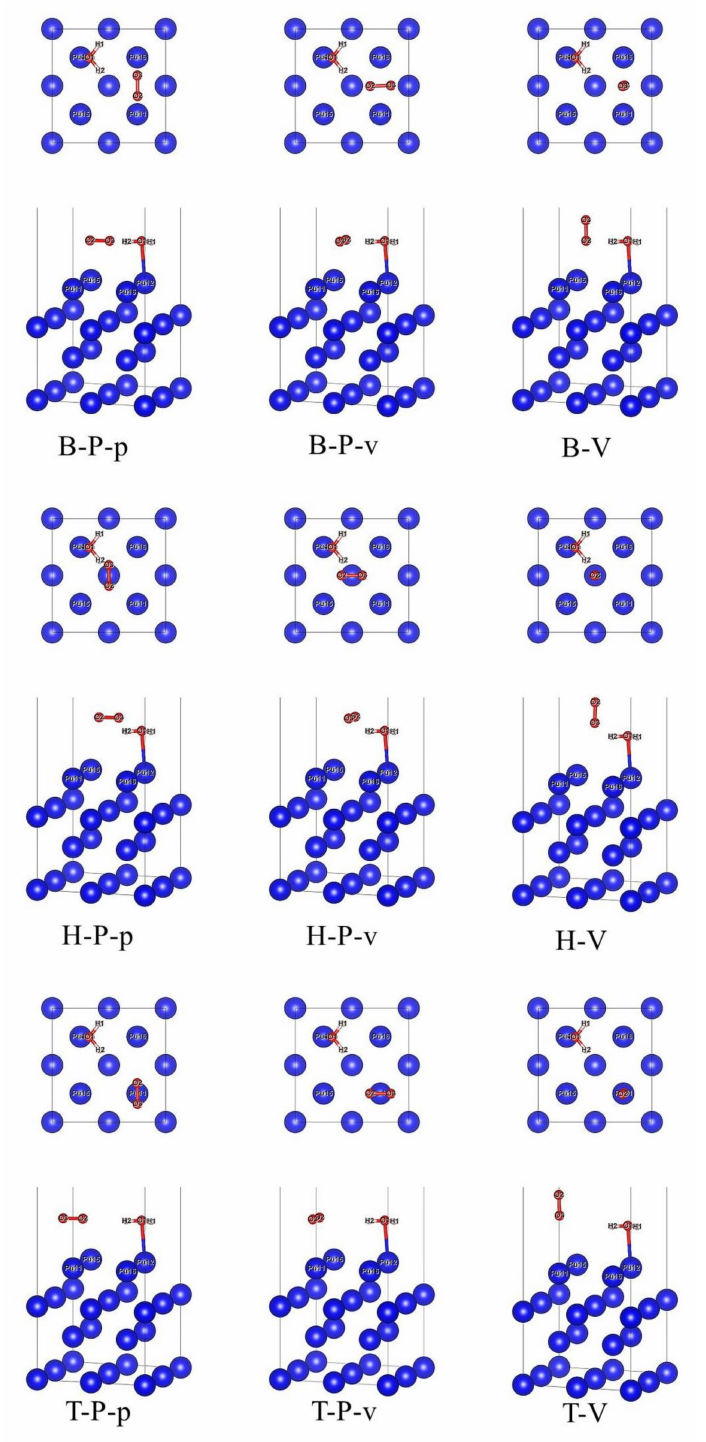
Figure 2. Initial co-adsorption model based on the most stable adsorption configuration of H 2 O single